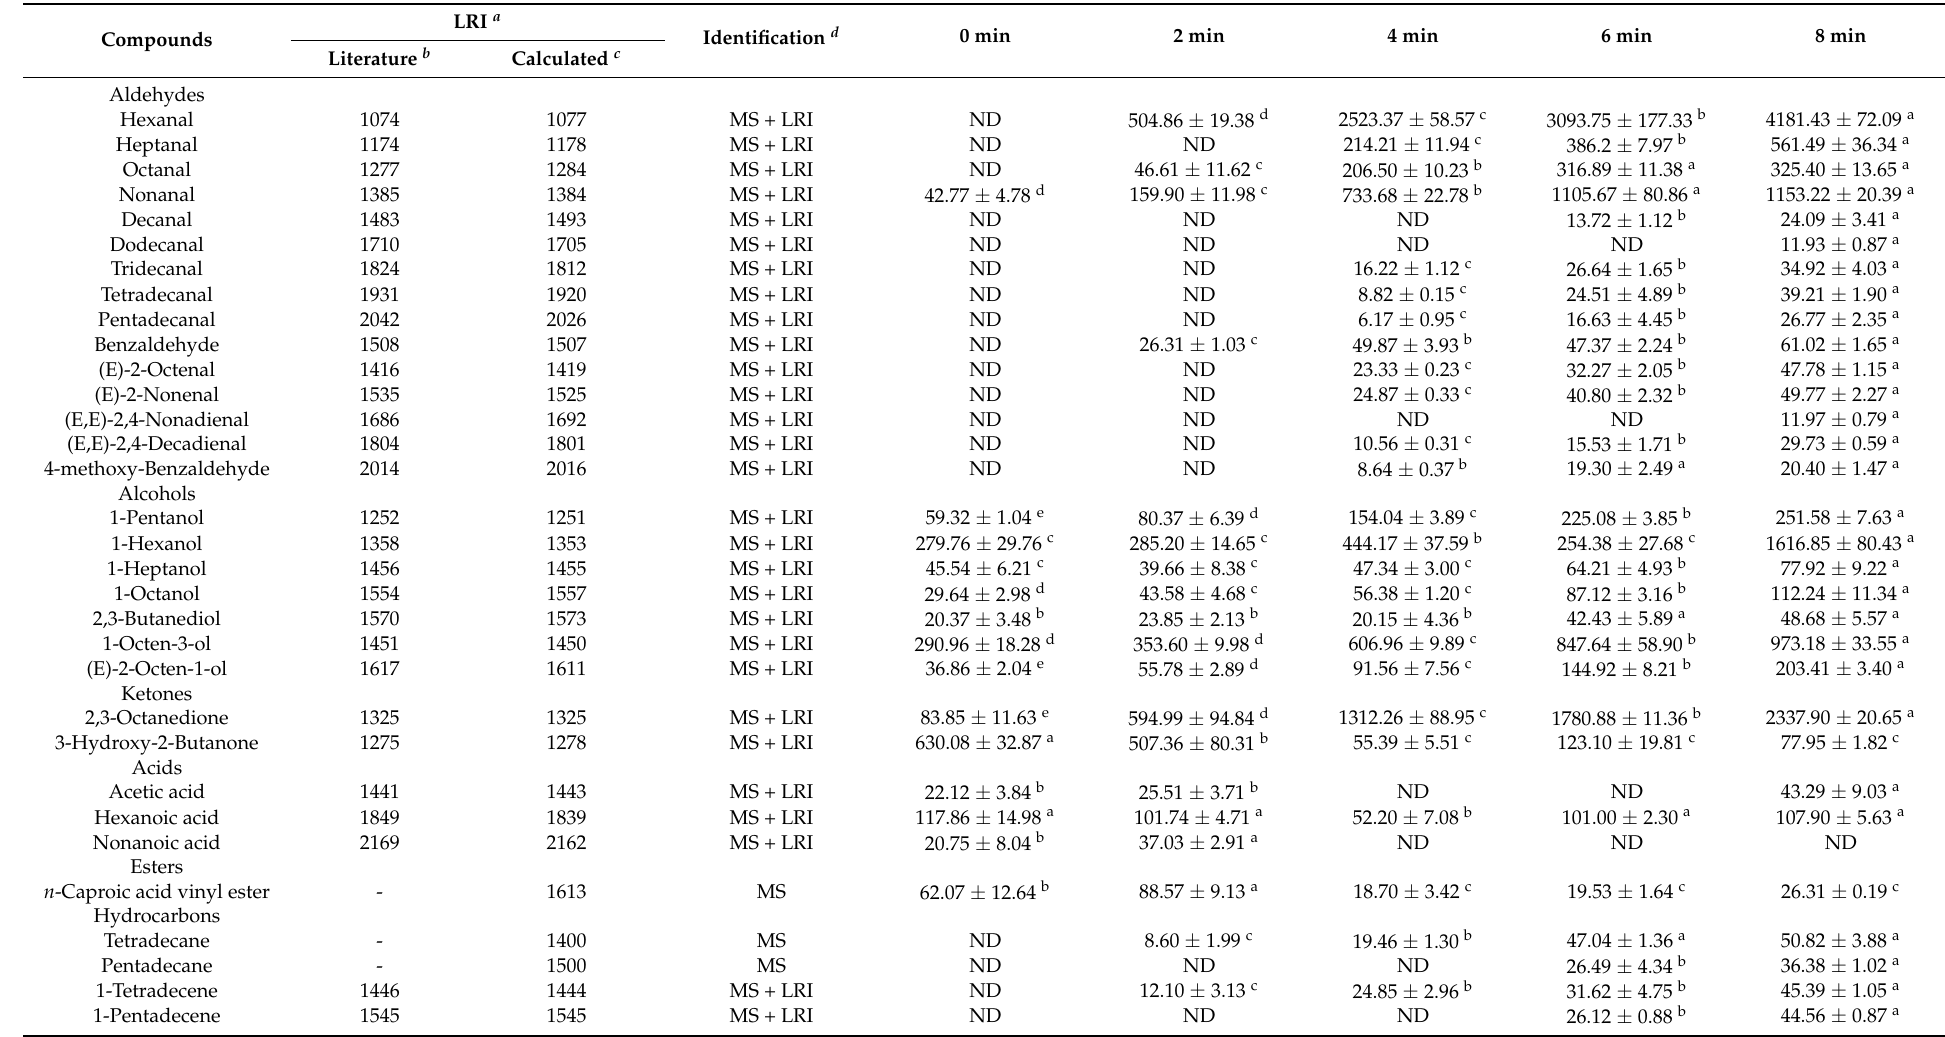
Table 2. Volatile compounds in tamarix lamb roasted by charcoal